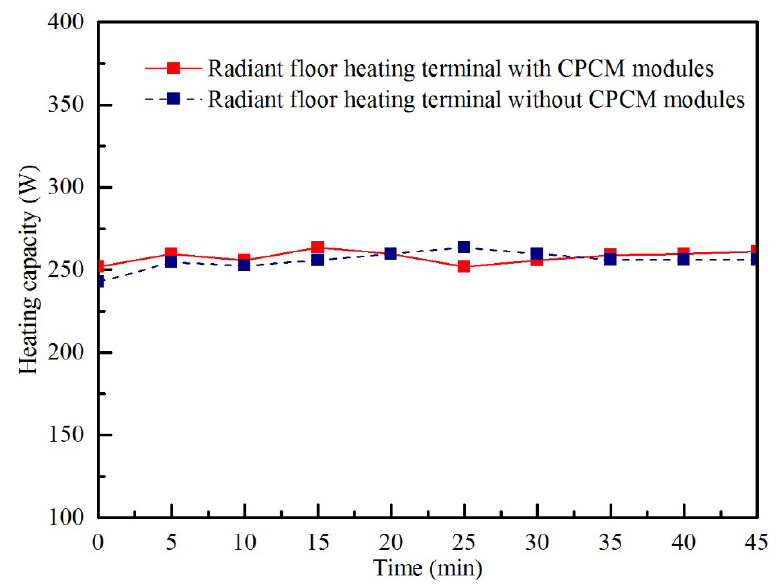
Figure 9. Heating capacity variations of radiant floor heating terminal with and without CPCM modules in the steady state of heating condition.